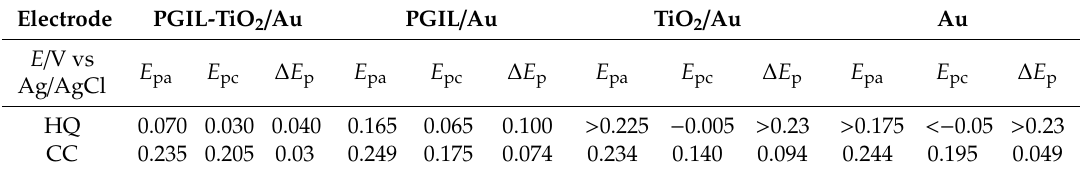
Table 1. Electrochemical parameters of CC and HQ on different modified electrodes.